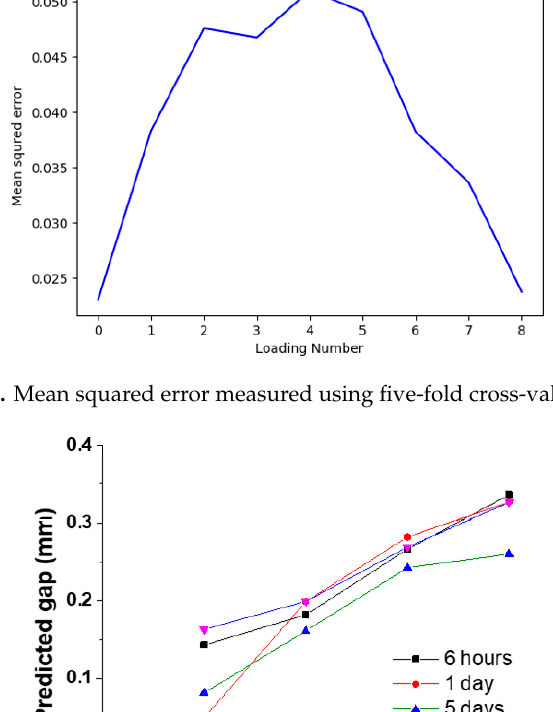
Figure 6. Mean squared error measured using five-fold cross-validation.